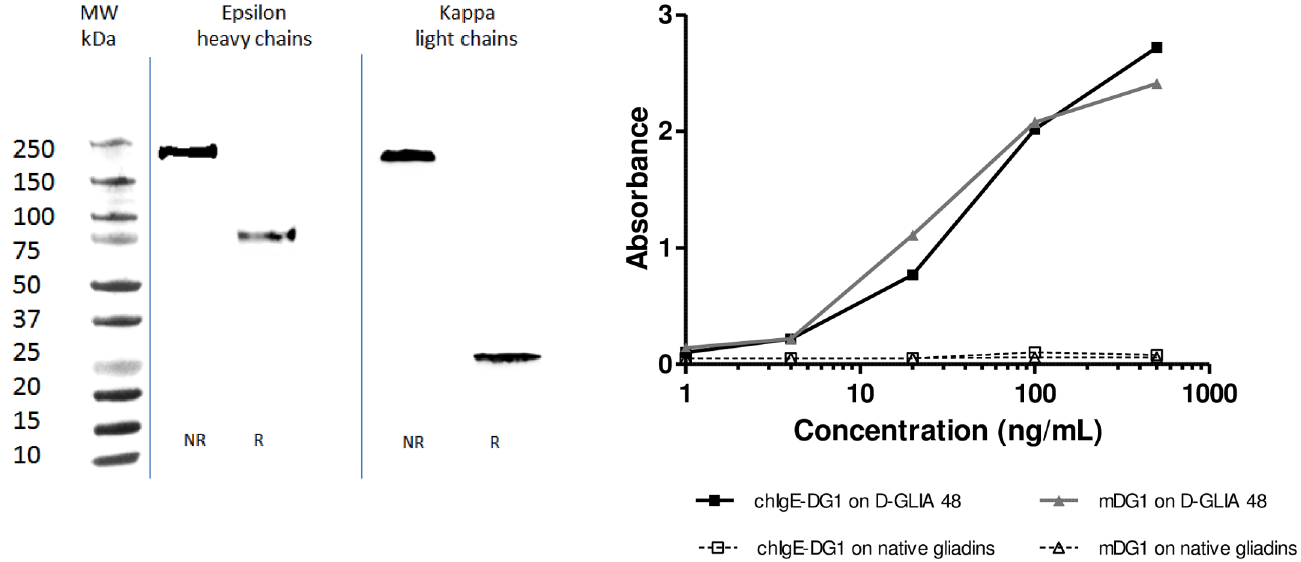
Fig 4. Characterization of chimeric mouse/human IgE-DG1. Chimericmouse/human IgE-DG1 was transiently expressedin HEK293cells, and the IgE concentrations were determinedby ELISA. A. Non-reduced (NR) or reduced(R) proteins from the supernatantof transfected HEK293 cells were separatedby SDS-PAGE (12%) and transferred onto nitrocellulose membrane. IgE heavy and kappa light chains were detected by peroxidase- conjugatedanti-human epsilonheavy chains or by anti-human kappa light chains, respectively, prior to chemiluminescent visualization. B. The activity and specificity of chimeric IgE-DG1 and its mouse monoclonal IgG counterpart (mDG1) were comparedby indirect ELISA. Native gliadin-or deamidatedgliadin(D-GLIA 48) -coated ELISA plates were incubatedwith indicatedconcentrations of chimeric IgE-DG1 or mDG1.